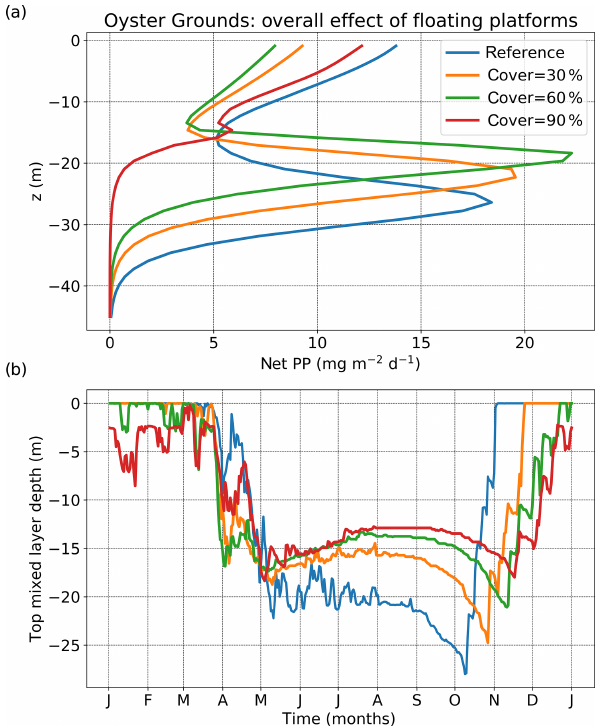
Figure 8. Vertical profiles of (a) net primary production and (b) yearly time series of top mixed layer depth (averaged over 1998– 2008) for the location of Oyster Grounds. The results are presented for different scenarios of coverage under the overall effect of float- ing platforms.